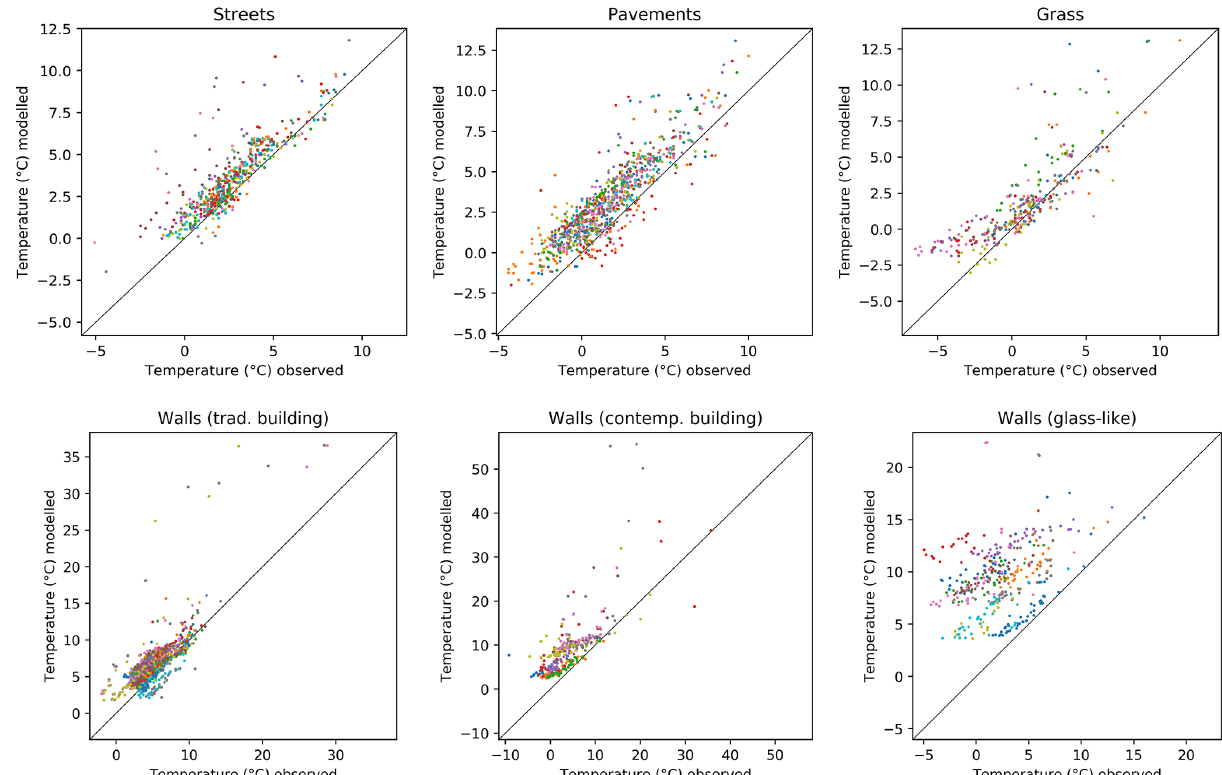
Figure 13. Scatter plots of the modelled and observed surface temperature for particular types of the surfaces in Table S7 during the winter e3 episode. Individual evaluation points are plotted using dots of different colours. Table 2. Statistics of observed and modelled surface temperatures (K) for the simulated summer e2 and winter e3 episodes. All times Daytime Night-time Surface